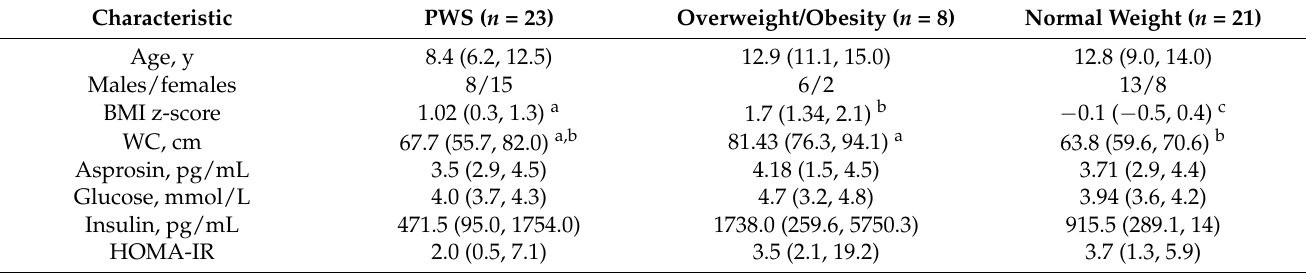
Table 1. Characteristics of children with Prader–Willi syndrome (PWS), children with obesity, and children with healthy weight.